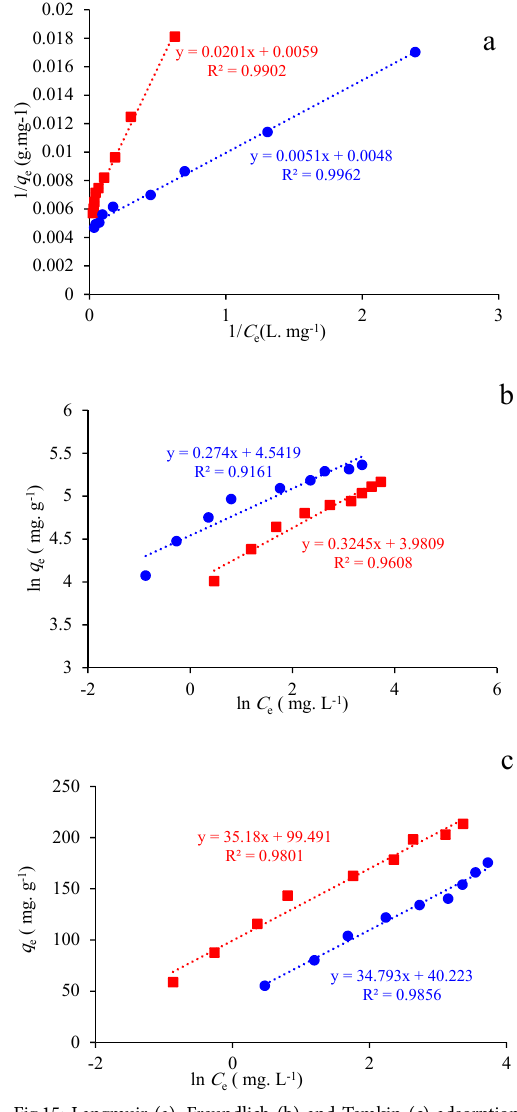
Fig.15: Langmuir (a), Freundlich (b) and Temkin (c) adsorption isotherms for MB adsorption on Fe